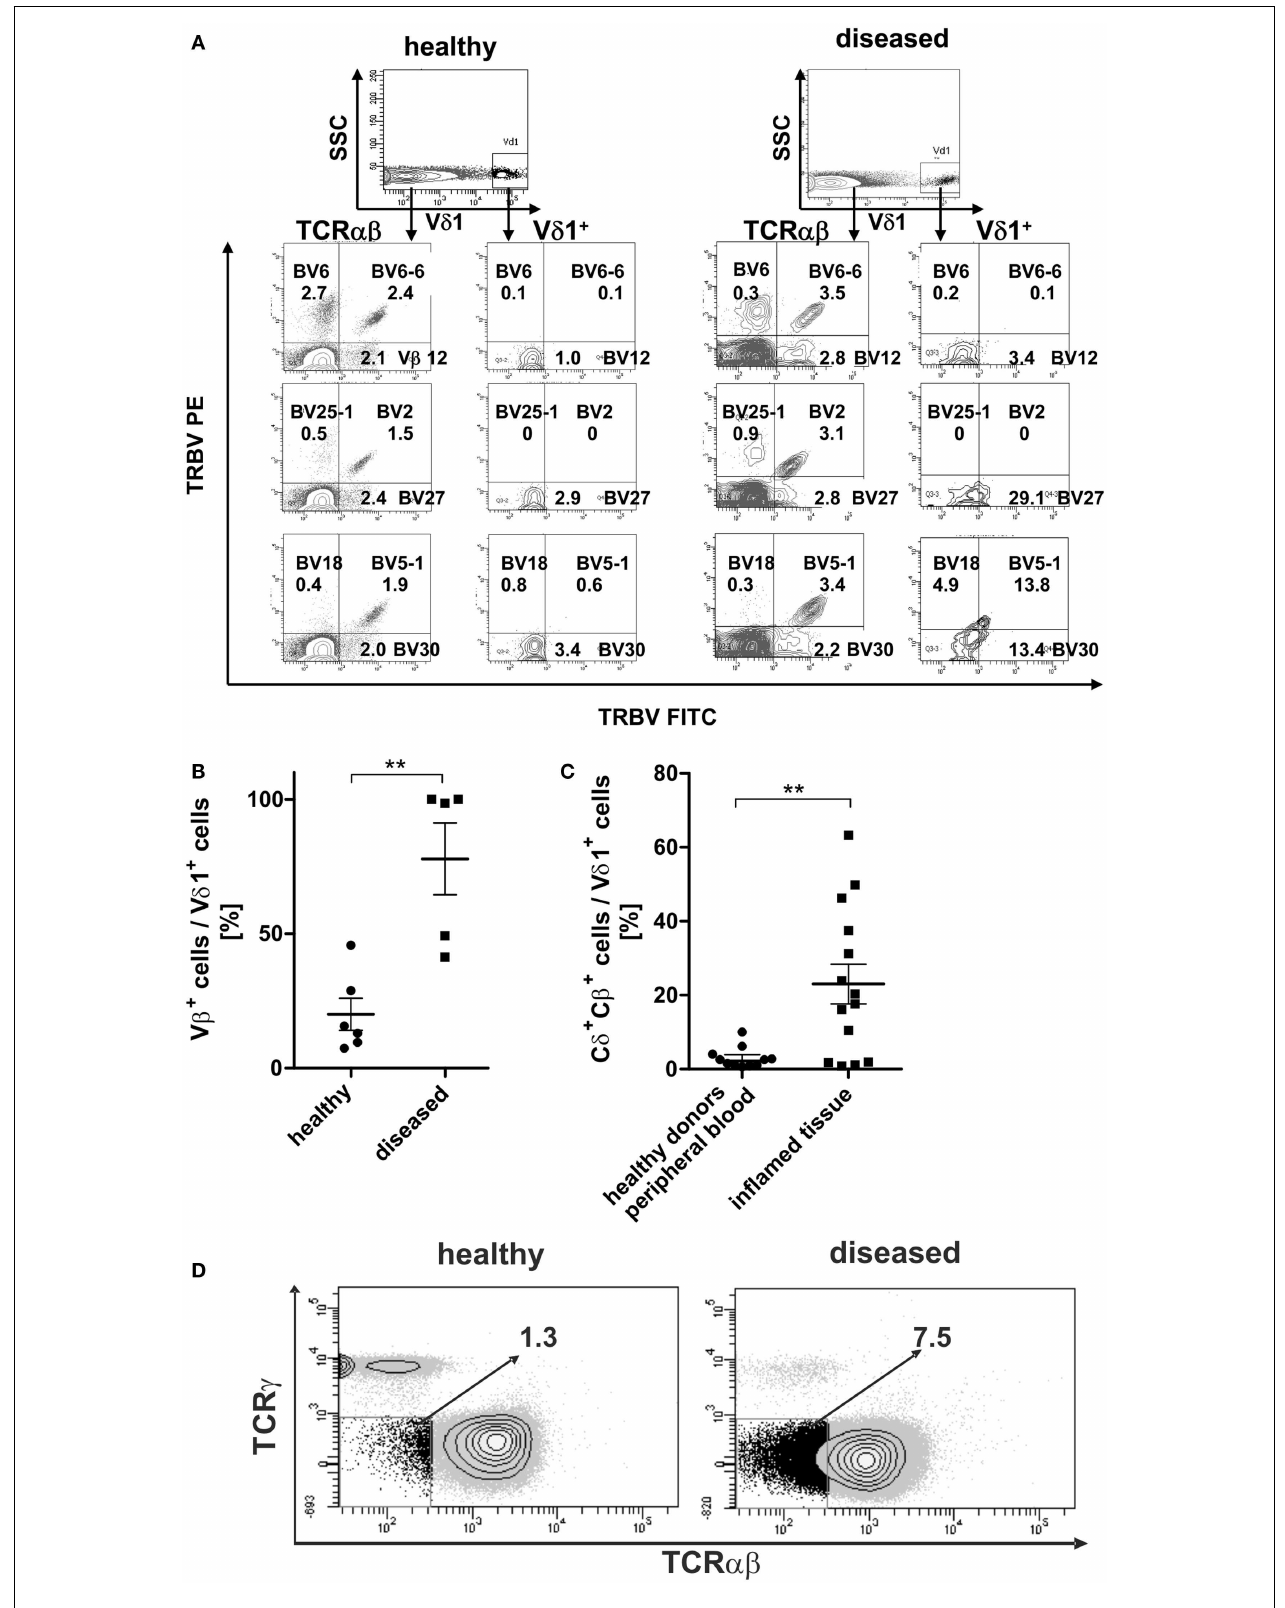
FIGURE 11 | SurfaceV β expression of αβ T cells in comparison with peripheralV δ 1 + T cells in healthy and diseased individuals